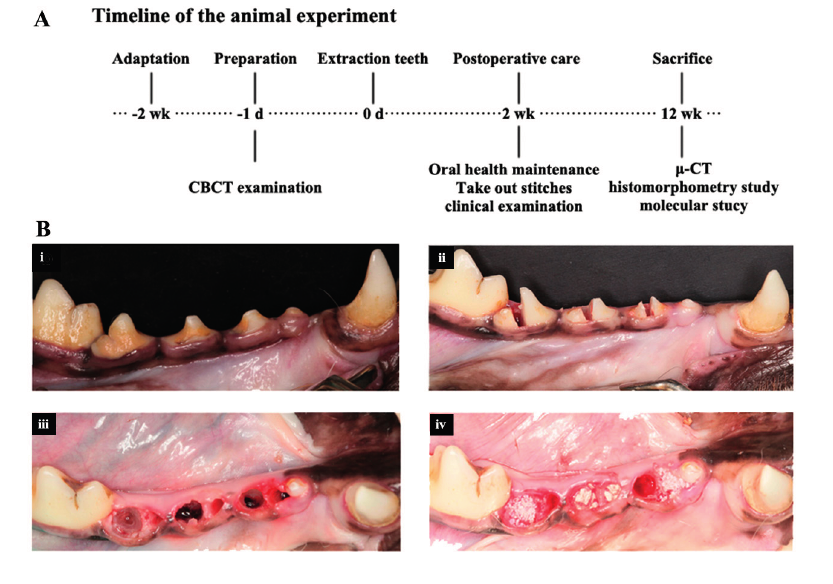
Figure 8. ( A ) Timeline of the treatment; ( B ) Treatment groups. ( i ) The 2nd, 3rd,